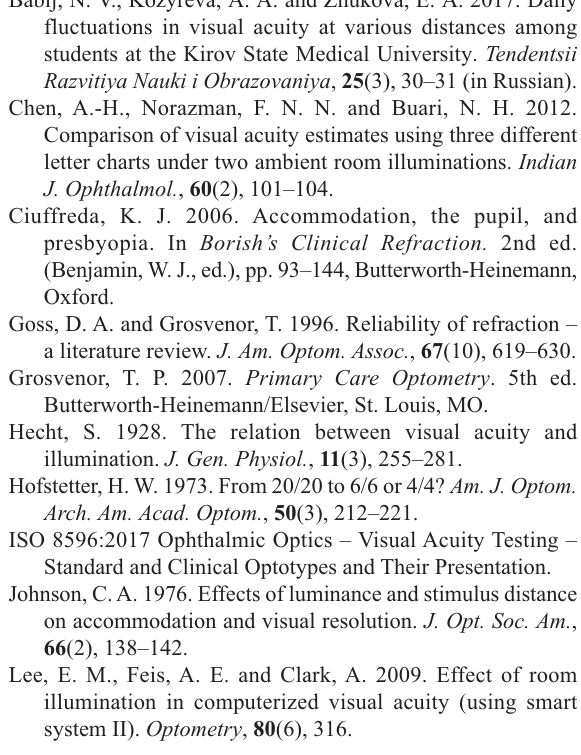
Comparison of visual acuity estimates using three